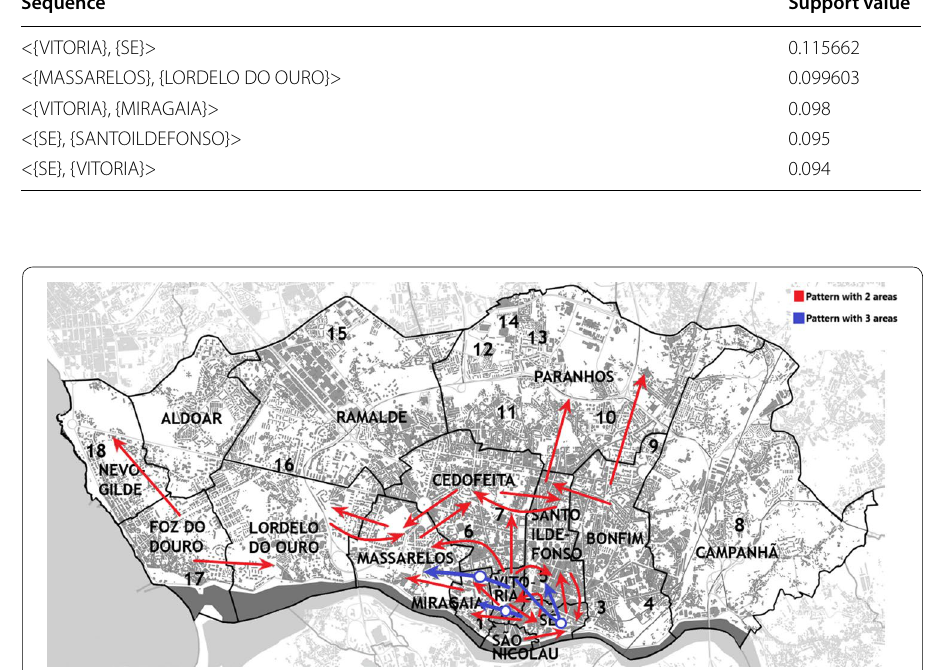
Fig. 14 Taxi trips flow over different districts in Porto